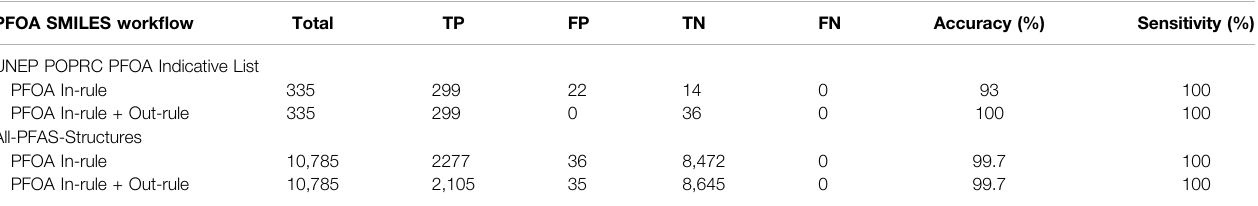
TABLE 1 | Confusion matrix relating the performance of the PFOA SMILES Work fl ow, separating In-rule and In-rule + Out-rule, when applied to the 10,794 SMILES contained in the PFASSTRUCT+ fi le where TP = #True Positives, FP = #False Positives, TN = #True Negatives, FN = #False Negatives, Accuracy=(TP + TN)/Total, Sensitivity = TP/(TP + FN).